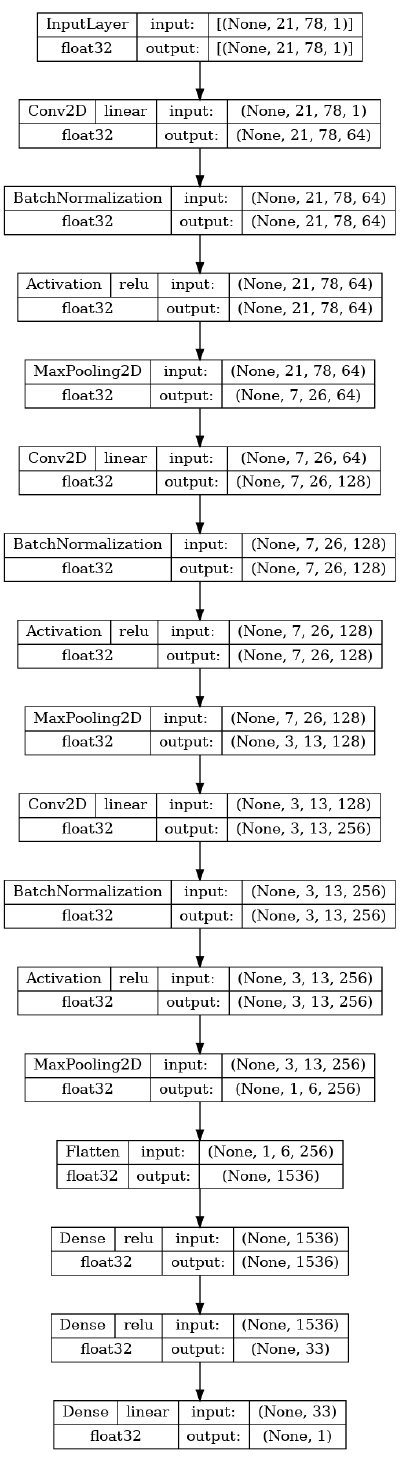
Figure 4. Architecture of the SMILES-based regression